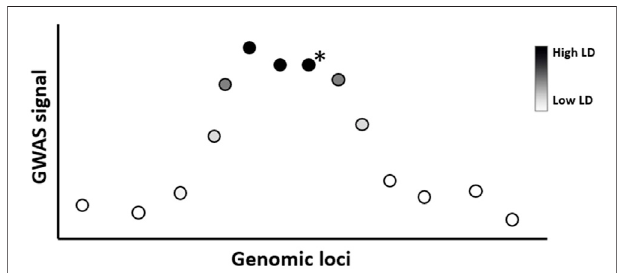
FIGURE 3 | Lead SNPs in GWAS studies need not be the causal variant due to linkage disequilibrium. Illustration of GWAS result where SNPs (circles) are colored according to linkage disequilibrium (LD) strength with the true causal variant within the locus (indicated with a black star). Due to LD, several SNPs near the true causal variant may show a statistically signi fi cant association with the phenotype. In ML, these highly correlated SNPs can be considered redundant to each other, therefore only one representative SNP for this LD cluster is required as a selected feature. In this example, the causal variant is not the variant with the strongest GWAS association